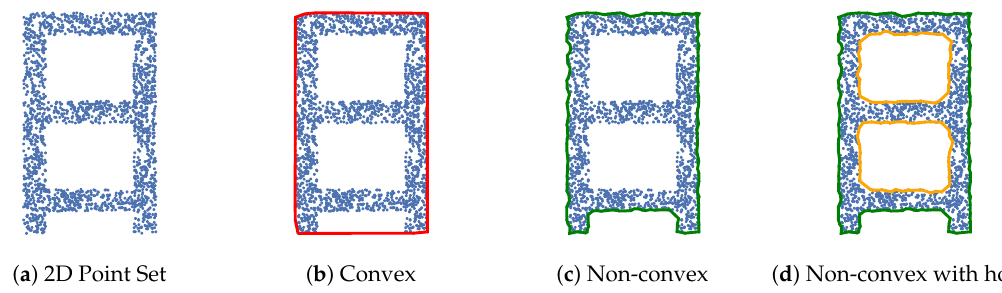
Figure 2. Example polygons that can be generated from plane segmented point clouds. ( a ) 2D point set representation of a floor diagram with interior offices; ( b ) Convex polygon; ( c ) non-convex polygon; ( d ) and non-convex polygon with holes. The exterior hull (green) and interior holes (orange) are indicated. Biswas et al. [11] represents flat surfaces as convex polygons extracted from range